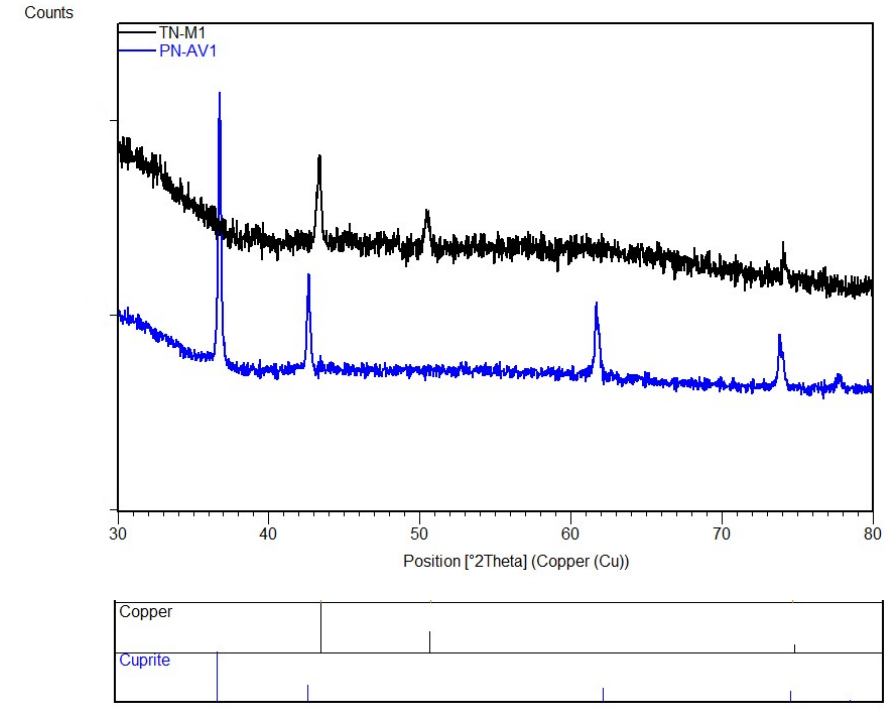
Figure 13. XRPD patterns of tesserae opacified by copper phases; note the presence of metallic copper in TN-M1 (black line; similar pattern shown by TN M2 and TN M3) and of cuprite in PN-AV1 (blue line; similar pattern shown by PN-AV2 and TN AV1).